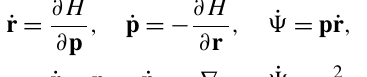
Figure 2. Impact parameter multipath, old coordinate (impact pa- rameter) lines, and modified coordinate